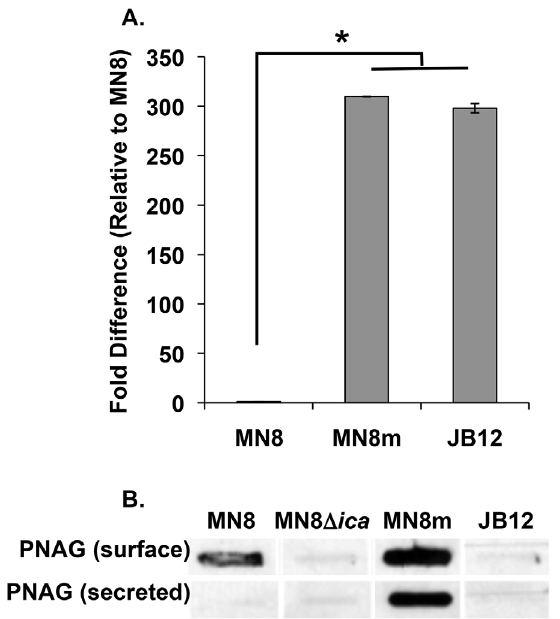
Figure 3. PIA/PNAG production in the non-mucoid variant. A. Real-time RT-PCR analysis of icaC mRNA transcript was performed. Bars represent the mean fold difference in transcript amount relative to strain MN8 with n=3, and error bars indicate the standard deviations. Statistical comparison (unpaired t test) of MN8m and JB12 versus MN8 gave a P value of , 0.001. B. EDTA extractions of surface-associated PIA/ PNAG, and spent medium from cultures (secreted polysaccharide) were blotted and probed with PNAG antiserum (MN8m extracts and spent medium were diluted 1:100).